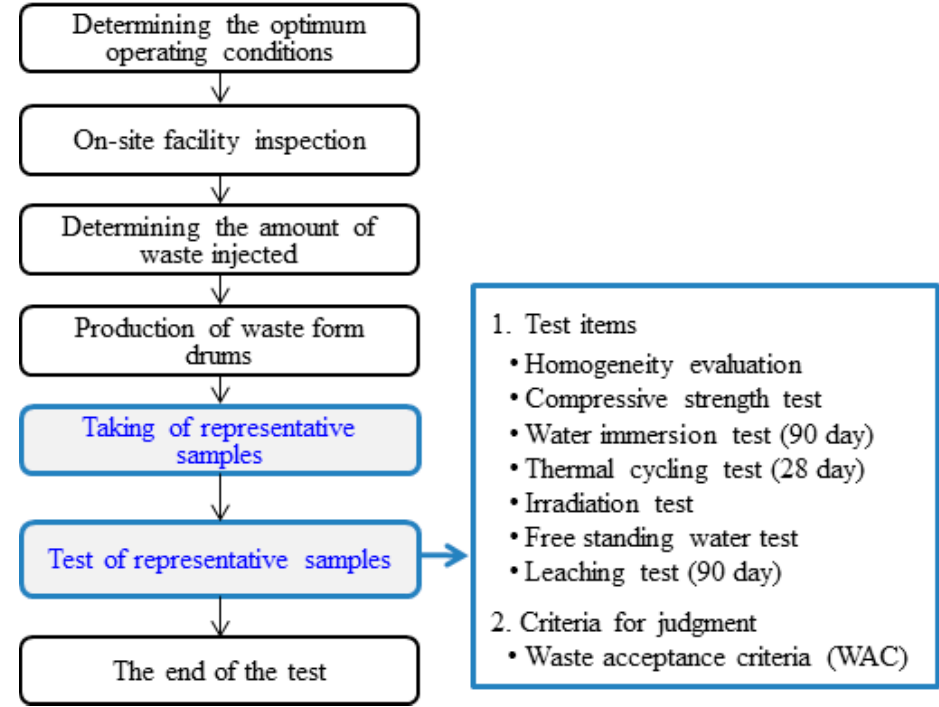
Figure 1. Flowchart and test items for waste forms to assess the utility of the cement solidification process.